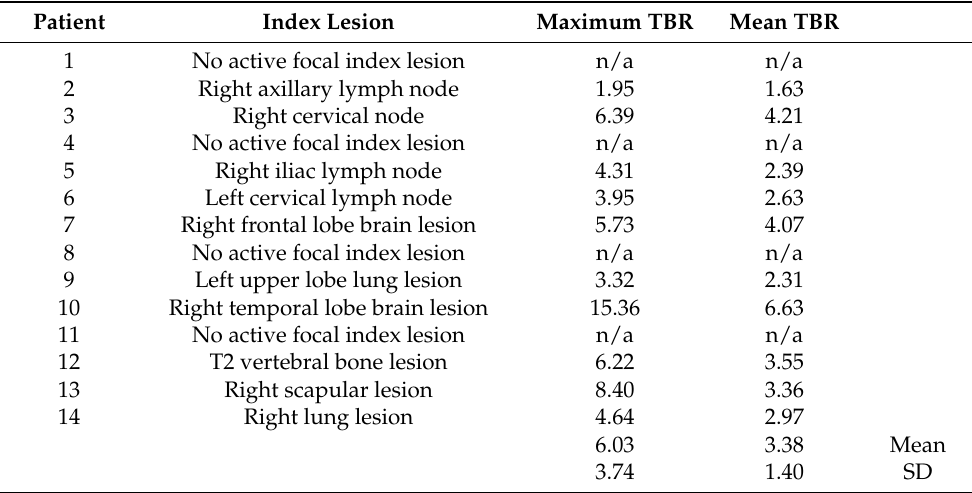
Table 2. The tumor-to-background (TBR) of NM4040 in index